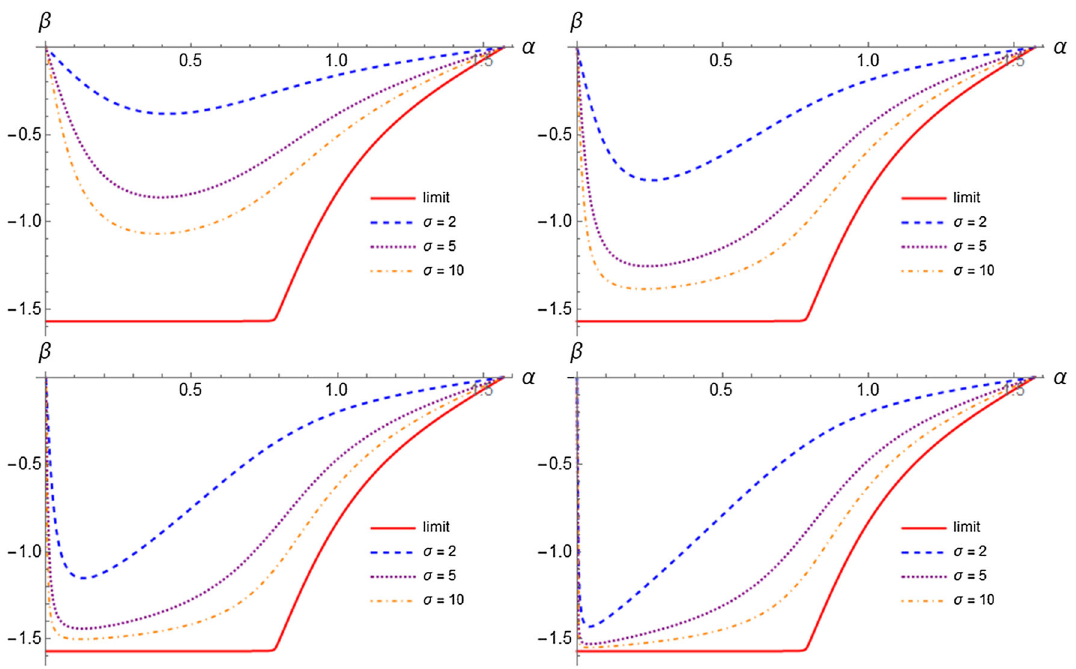
Fig. 4 Plot of the deflection angle β = α (cid:2) − α as a function of the initial angle α for σ = 2 (dashed line), σ = 5 (dotted line) and σ = 10 (dash-dotted line) for ξ = 5 (top left), ξ = 20 (top right), ξ = 100 (bottom left), ξ = 1000 (bottom right). Each plot contains the limiting curve σ → ∞ , ξ → ∞ (solid